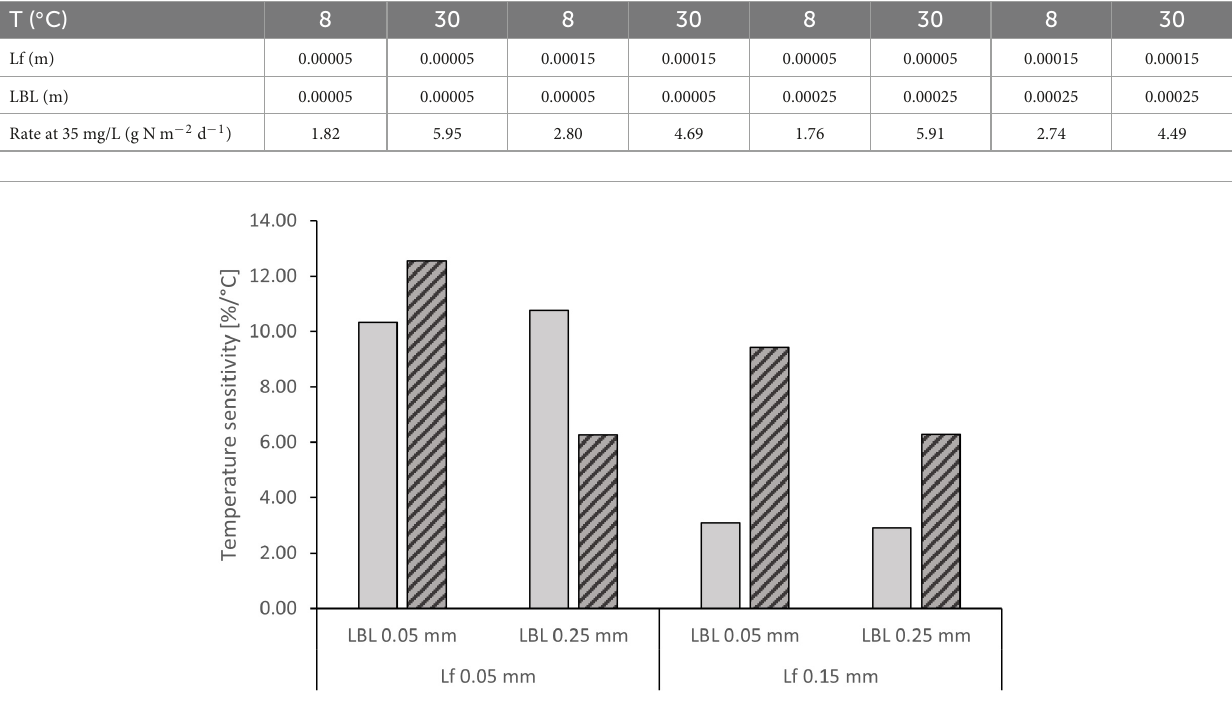
FIGURE6 Temperature sensitivity of NH 4 + -N removal rate at 35 mg/L ( ) and 0.1–1.0 mg/L ( ) NH 4 + -N concentration at various combinations of biofilm thickness (Lf) and boundary layer thickness